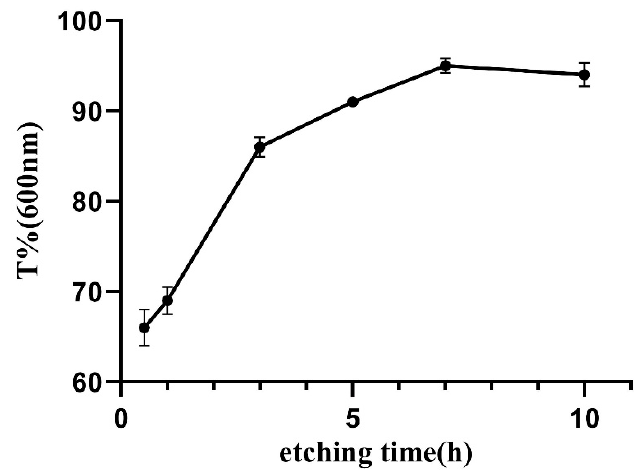
Figure 7. Digital photos of fresh fish scales ( a ), decalcified fish scales ( b ), fish scale collagen lamel- lar matrix ( c ) and contact lens ( d ).